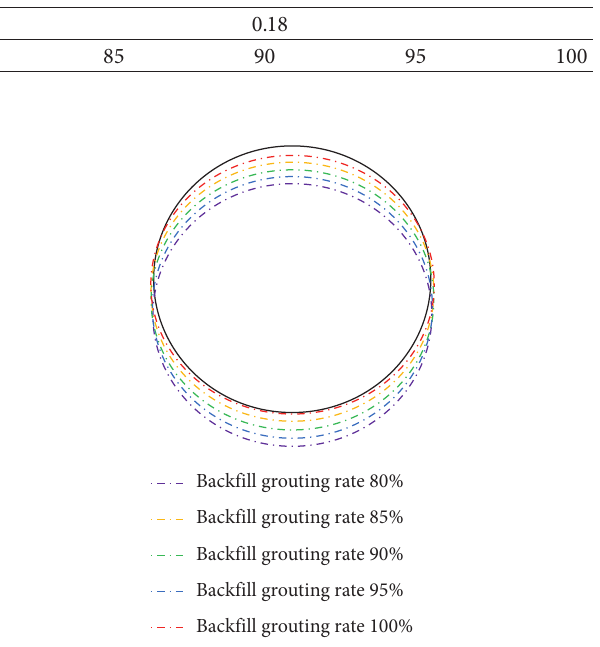
Figure 9: Simulation diagram of grout filling in shield tail gaps. (a) The segment off the ring. (b) Incomplete grout filling. (c) Convergent unit simulation. Table 13: Conditions of uniform filling grouting.